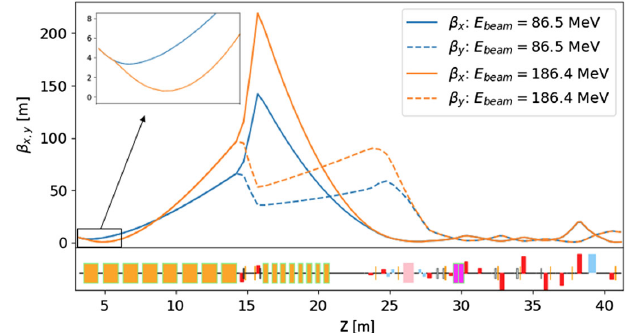
resolution.FIG. FIG. 7. Changes of the Twiss parameters in the dump section during dispersion FIG. 8. Some details of longitudinal beam dynamics for the beam energy 136 MeV. (a) The longitudinal phase space (LPS) beam distribution in front of the dump magnet, (b) slice energy spread of the beam in front of dump magnet, (c) the beam image on the OTR screen, and (d) horizontal slice beam size on the OTR screen without effect of the screen